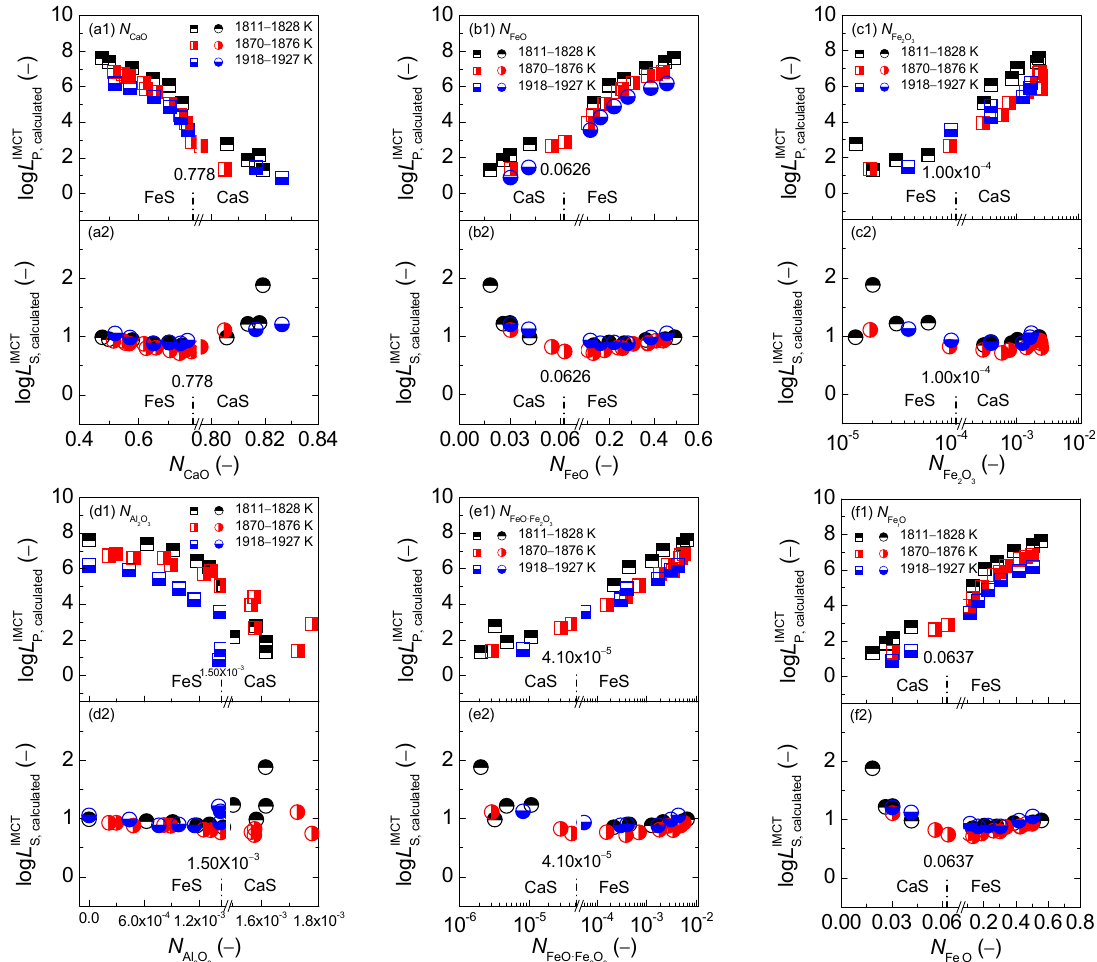
Figure 1. Relationship of the calculated [3] mass action concentration N i of CaO ( a ), FeO ( b ), Fe 2 O 3 ( c ), Al 2 O 3 ( d ), FeO · Fe 2 O 3 ( e ), and Fe t O ( f ) against the calculated [3] phosphorus distribution ratio log L IMCT by IMCT– L P model in the first layer or calculated [4] sulfur distribution ratio log L IMCT by IMCT– L S model in the second layer for CaO–FeO–Fe 2 O 3 –Al 2 O 3 –P 2 O 5 slags equilibrated with liquid iron over a temperature range of 1811 to 1927 K (1538 to 1654 ◦ C), respectively.